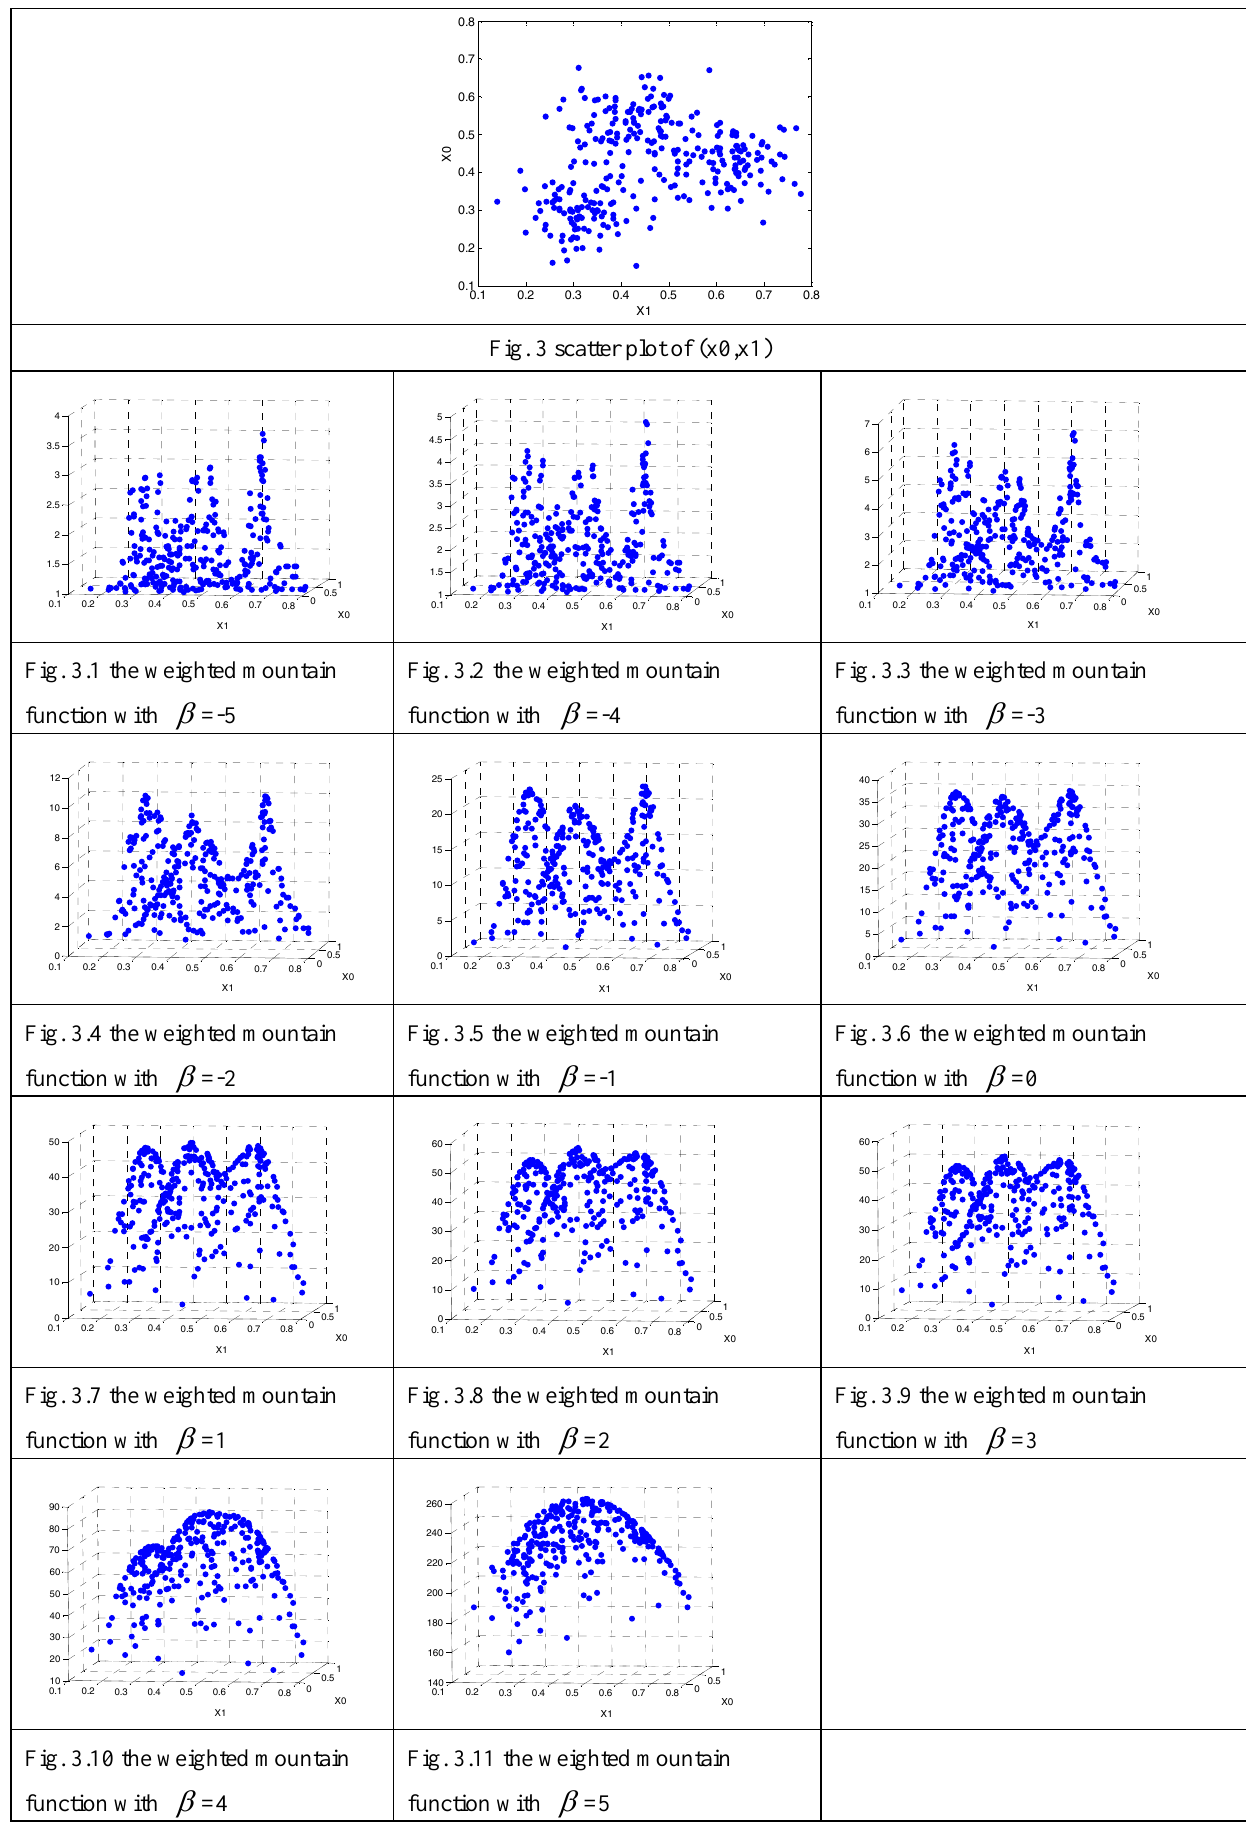
Fig. 3.11 the weighted mountain function with 